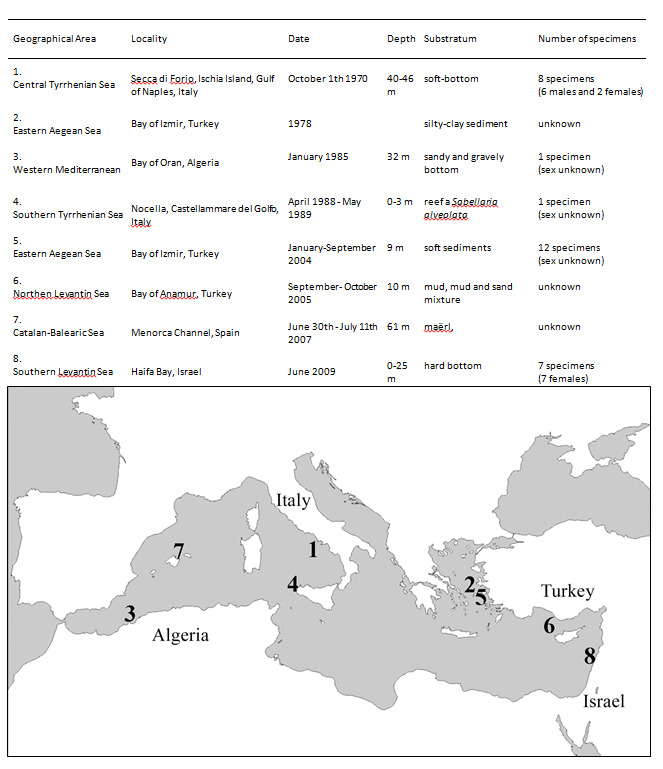
Records of Maera
schieckei in the Mediterranean Sea pointed out in the map below.Details of the records in the Table above, from the following references: Bakalem et al. 2014, Bakir and Katağan 2014, Çinar et al. 2006, Junoy and Viéitez 2008, Karaman and Ruffo 1971, Kocataş and Katağan 1978, Lo Brutto 1991.